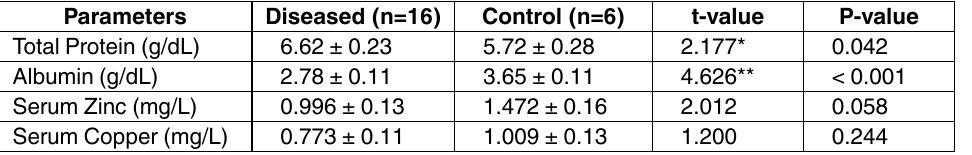
table 2. Mean values of serum total protein, albumin, zinc and copper of diseased and control